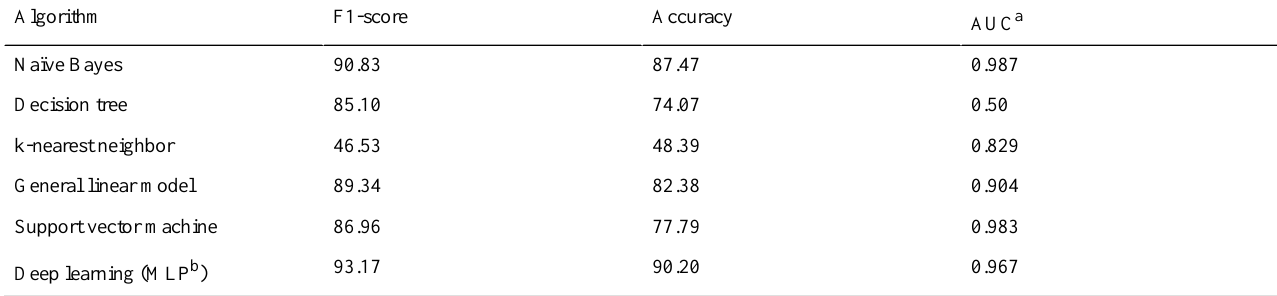
Table 4. Comparative results of the deep-learning model with shallow machine-learning models.